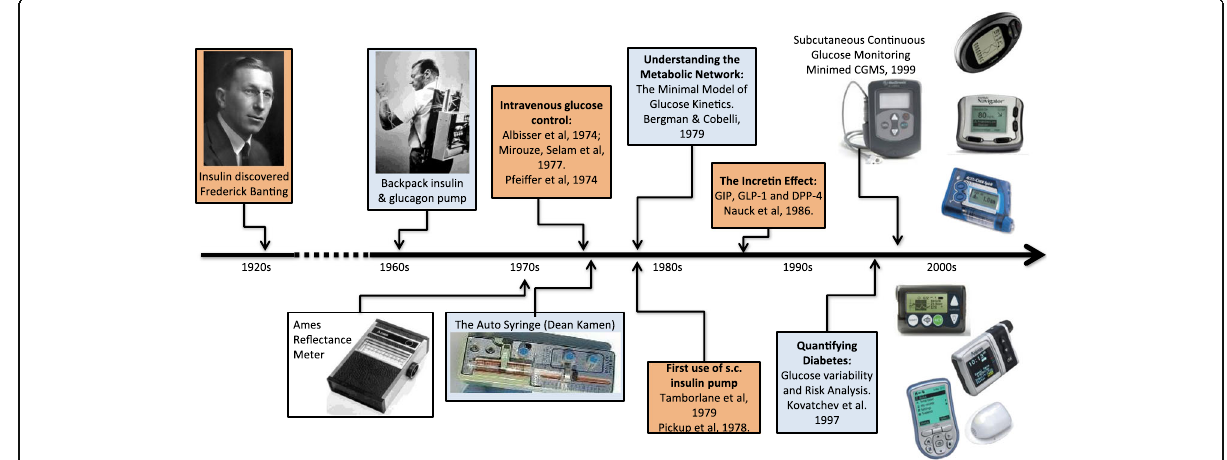
Fig. 2 Timeline of diabetes technology development following the discovery of insulin in